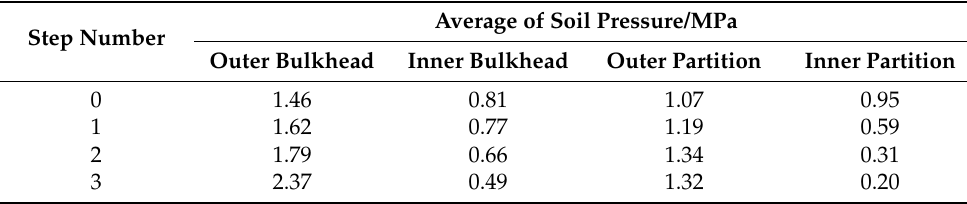
Table 3. Averages of the field soil pressure during soil excavation procedure.